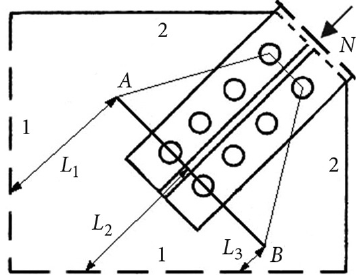
Fig. 8. Design of gusset plate in compression: 1 – clamped edge;